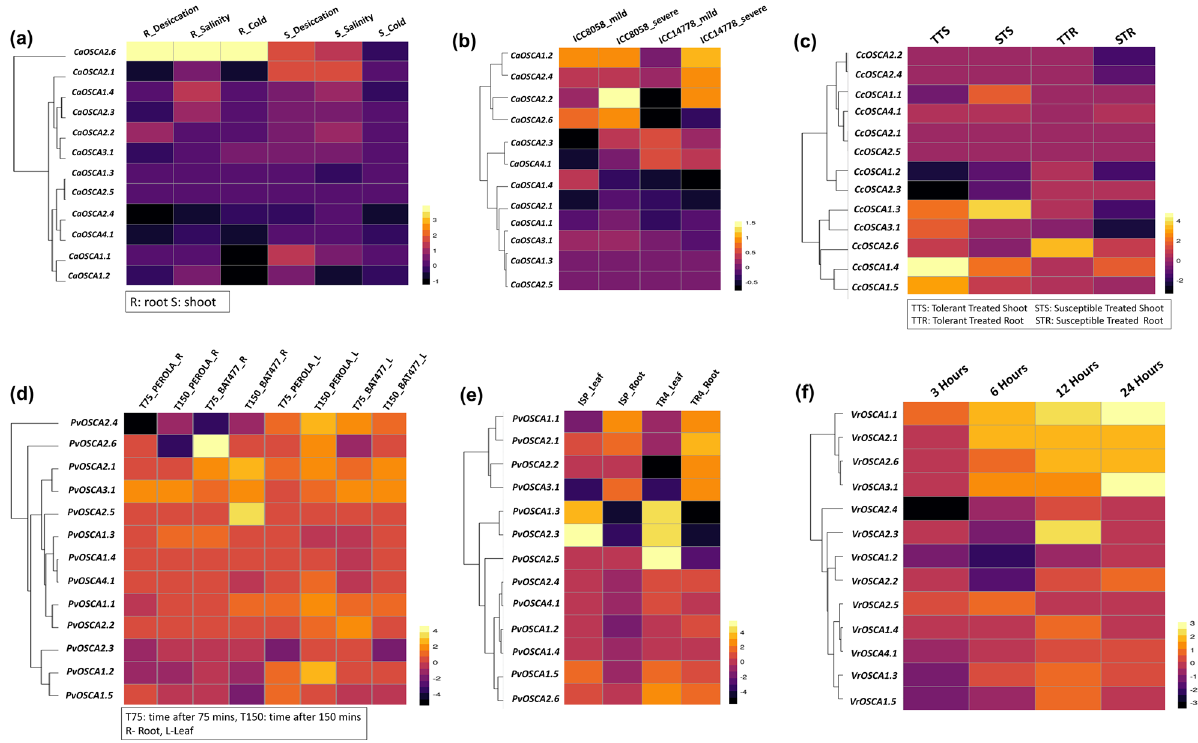
Figure 6. Expression profiles of OSCA genes in different abiotic stresses. The genes are named on the left, and condition/tissue is labelled at the top. The scale bar represents the log_2 Fold Change based on FPKM values; ( a ) Expression pattern of CaOSCA genes in three abiotic stress -cold, desiccation and salinity in the root (R) and shoot (S); ( b ) Expression pattern of CaOSCA genes in mild and severe drought stress; ( c ) Expression profiles of CcOSCA genes in salinity stress in ICP 7-salt-tolerant genotype (indicated by TTS-Tolerant treated shoot and TTR- Tolerant treated root), ICP 1071-Salt susceptible genotype (indicated by STS-Susceptible treated shoot, STR-Susceptible treated root); ( d ) Expression profiles PvOSCA genes in drought stress in two genotypes at two different time points; ( e ) Expression profiles of PvOSCA genes in salinity stress in the root (R) and leaf (L) in two genotypes; ( f ) Expression profiles of VrOSCA genes in desiccation stress at four different time